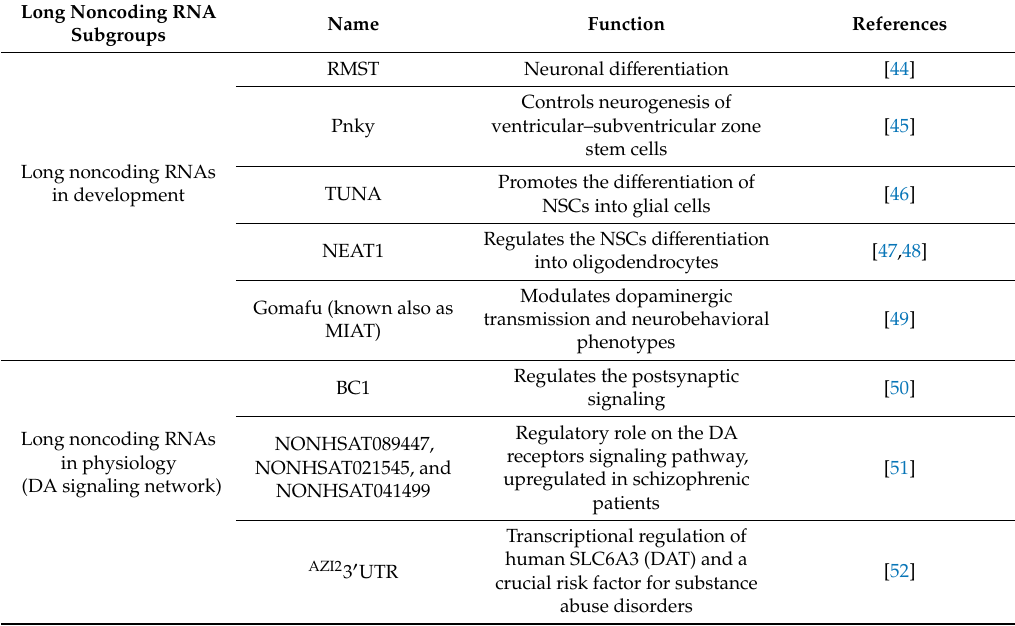
Table 2. Summary of long noncoding RNAs (lncRNAs) involved in DA signaling pathway in health and